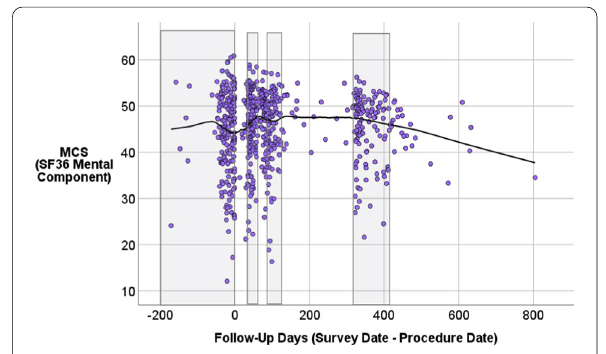
Fig. 2 Scatter plot of MCS scores over